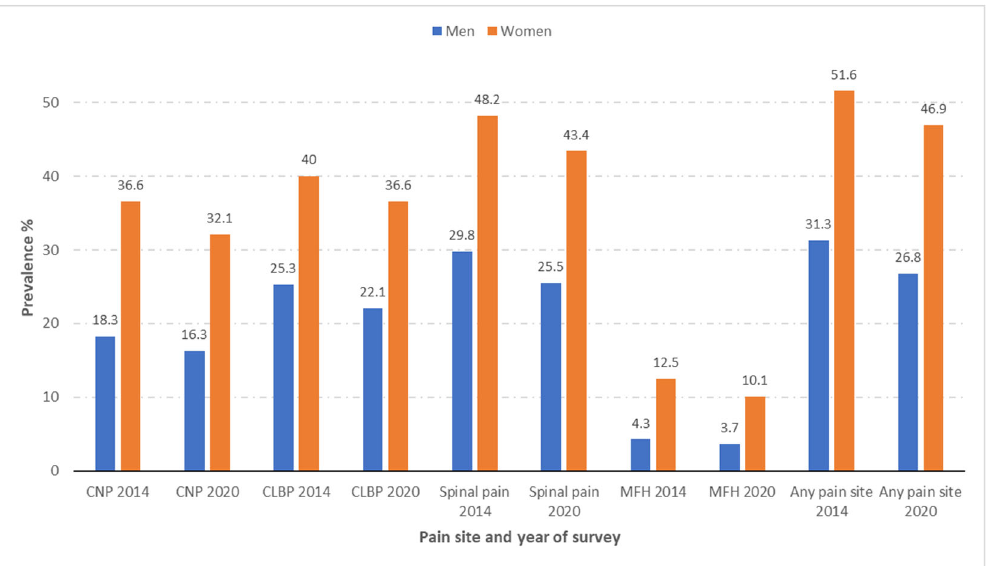
Figure 1. Prevalence of chronic neck pain (CNP), chronic low back pain (CLBP), spinal pain, and migraine or frequent headache (MFH), and any pain site according to sex among people with self- reported diabetes included in the European Health Interview Surveys for Spain (EHISSs) conducted in 2014 and 2020. Table 2. Prevalence of chronic neck pain, chronic low back pain, and migraine or frequent headache among subjects with diabetes and sex–age-matched subjects without diabetes according to sociode- mographic variables and pain